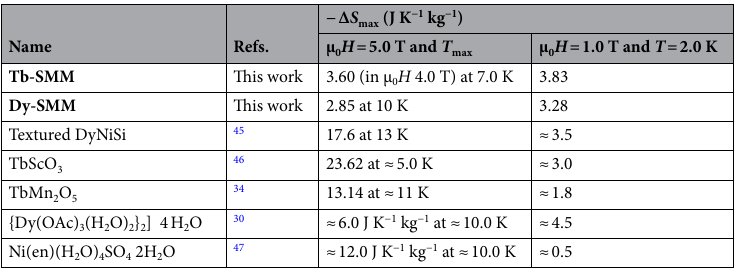
Table 1. Examples of rotating magnetocaloric properties of selected potential refrigerants.